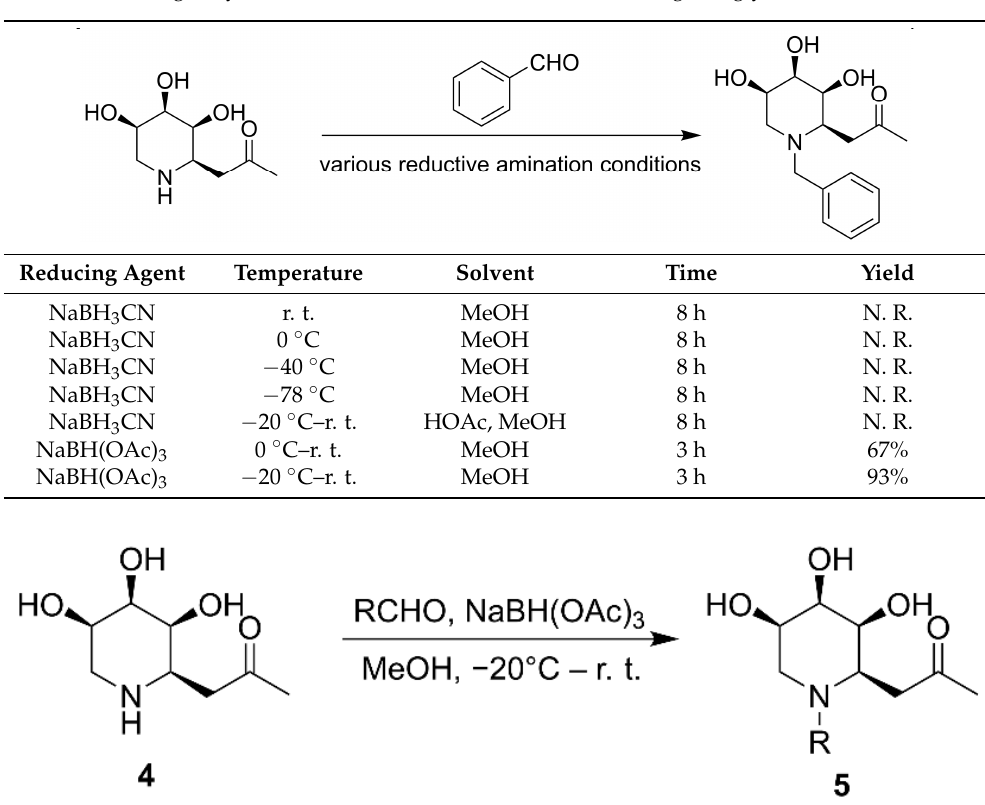
Scheme 2. Synthesis of N ‐ substituted iminosugar C ‐ glycosides.